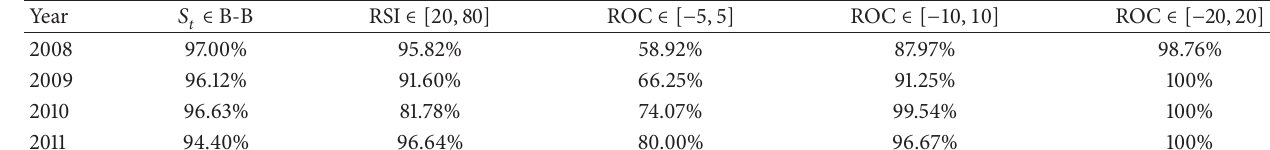
Table 2: Ratio of QQQ in 2008–2011.